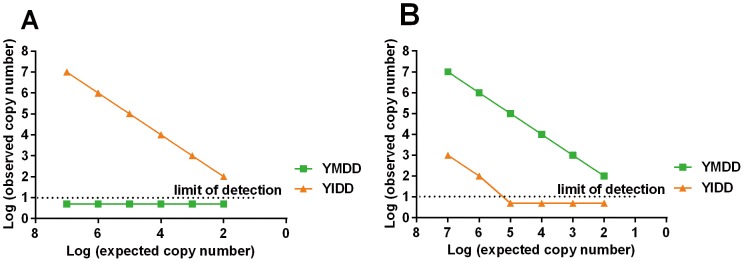
Cross-reactivity test of RT-AS-LNA-qPCR.(A) Specificity of mutant primer for detection of YMDD and YIDD plasmids. No nonspecific amplification was observed. (B) Specificity of wild-type primer for detection of YMDD and YIDD plasmids. Nonspecific amplification was detected at the concentration equal to or above 1×106 copies/μl, but the corresponding mismatch products decrease significantly.